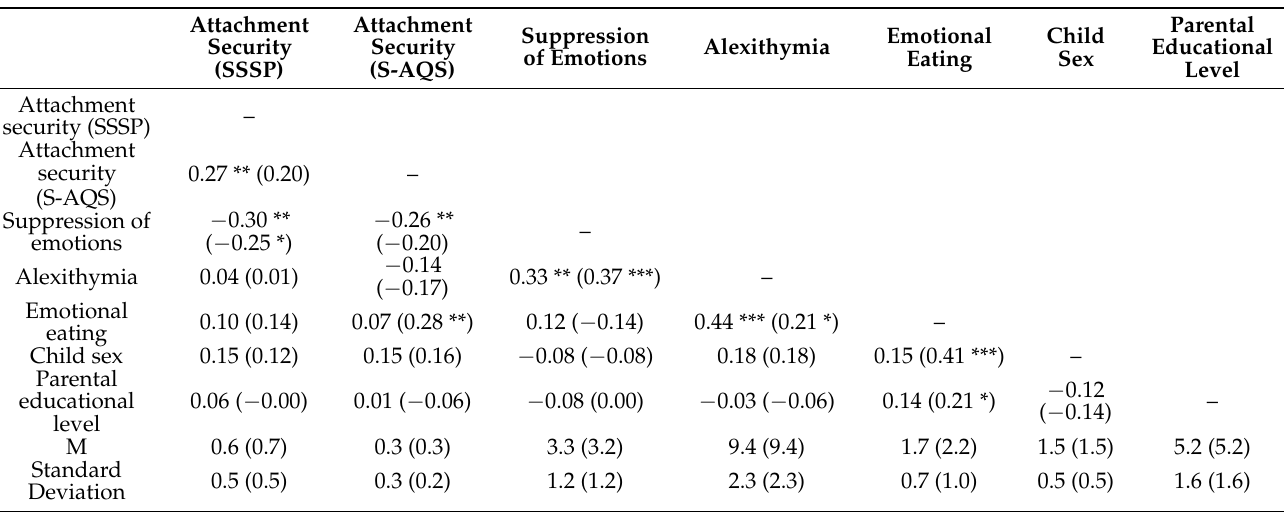
Emotional Child Eating